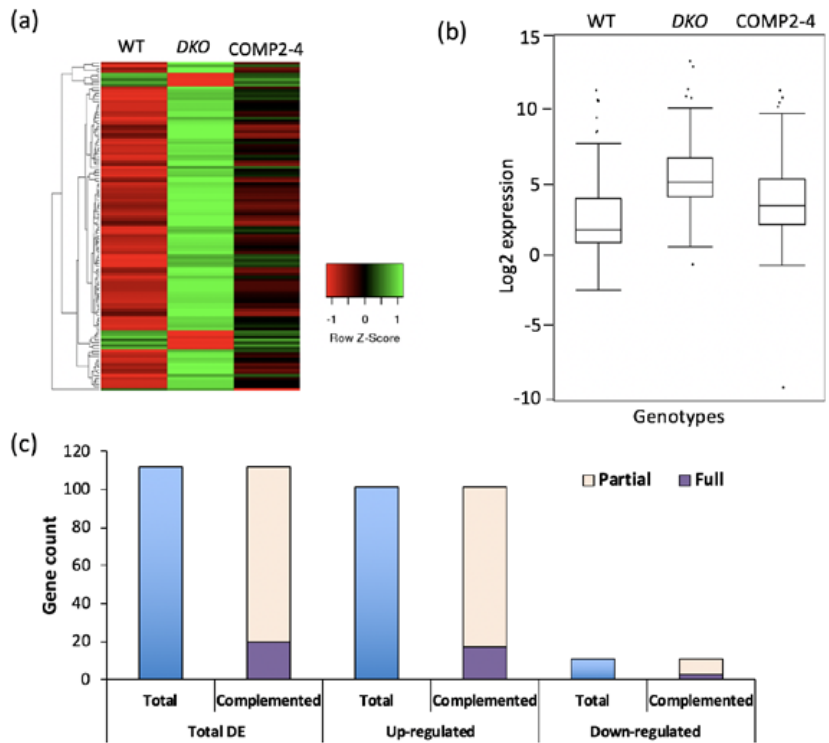
Figure 2. Analysis of differentially expressed genes. ( a ) Heatmap representation of differentially expressed genes in WT , DKO and COMP2-4 (COMP) plants. Expression values were used to generate the heatmap using the Heatmapper. Columns represent samples and rows represent genes. Color scale indicates the gene expression level. Green indicates high expression and red Indicates low expression. ( b ) Box-and-whisker plots showing expression of differentially expressed (DE) genes in different genotypes. ( c ) Gene counts of total, up and down-regulated DE genes that are either fully or partially complemented in COMP2-4 line.